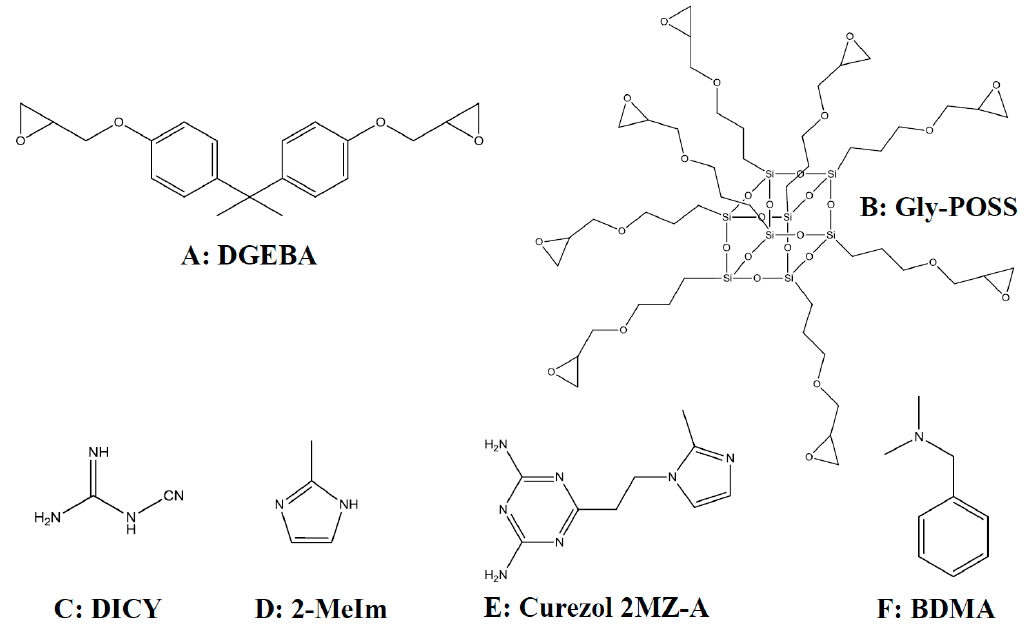
Figure 1. Structures of the precursors: ( A ) diglycidyl ether of bisphenol-A (DGEBA), ( B ) octaglycidyl-POSS (GlyPOSS), ( C ) dicyandiamide (DICY), ( D ) 2-methylimidazole (2-MeIm), ( E ) 2,4-diamino-6-[2’-methylimidazolyl-(1’)]-ethyl-s-triazine (Curezol) and ( F ) N,N -benzyl dimethylamine (BDMA).